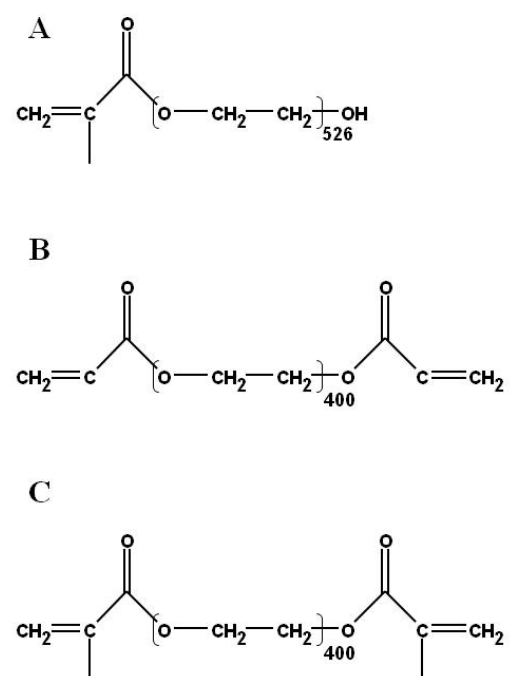
Figure 1. Chemical structures of (a) Poly(ethylene glycol) methacrylate, (b) Poly(ethylene glycol) diacrylate, and (c) Poly(ethylene glycol)